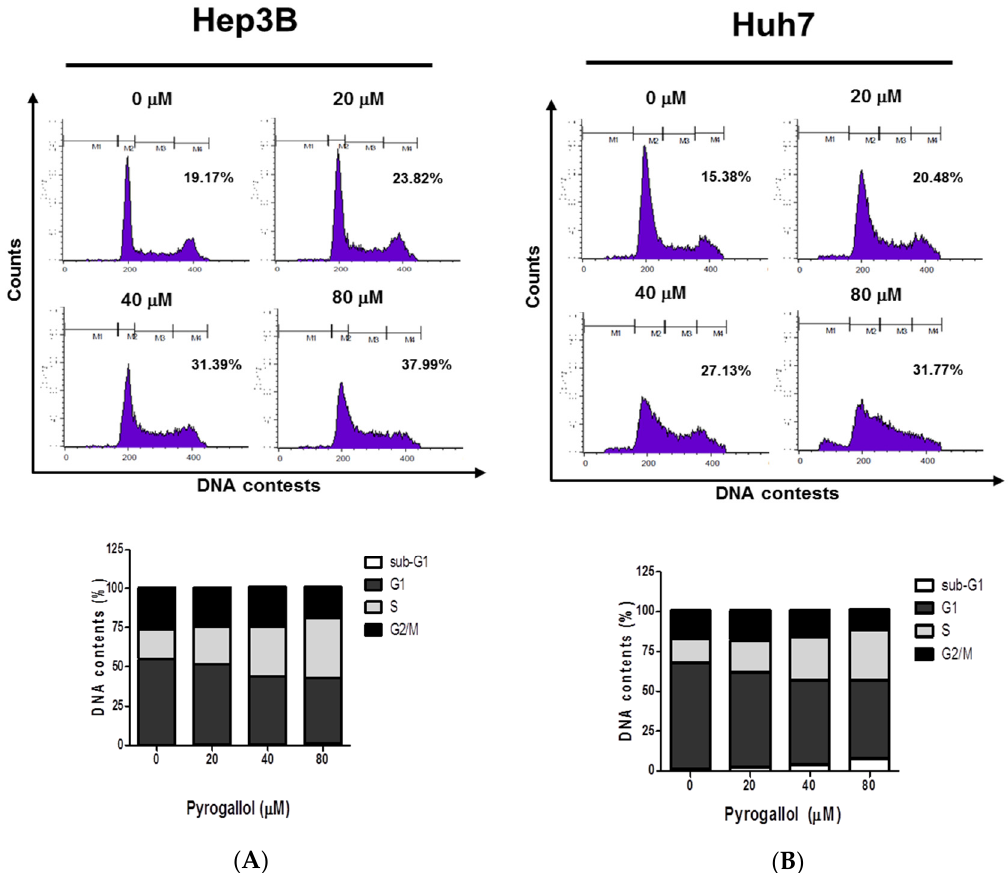
Figure 2. Pyrogallol induced S-phase arrest in Hep3B and Huh7 cells. ( A,B ) Hep3B and Huh7 cells were treated with Pyrogallol (0, 20, 40, 80 μ M) for 24 h. The cells were washed with PBS, fixed in 70% ethanol, stained with PI and then subjected to flow cytometric analysis. Graphs show each phase of the cell cycle population (%).